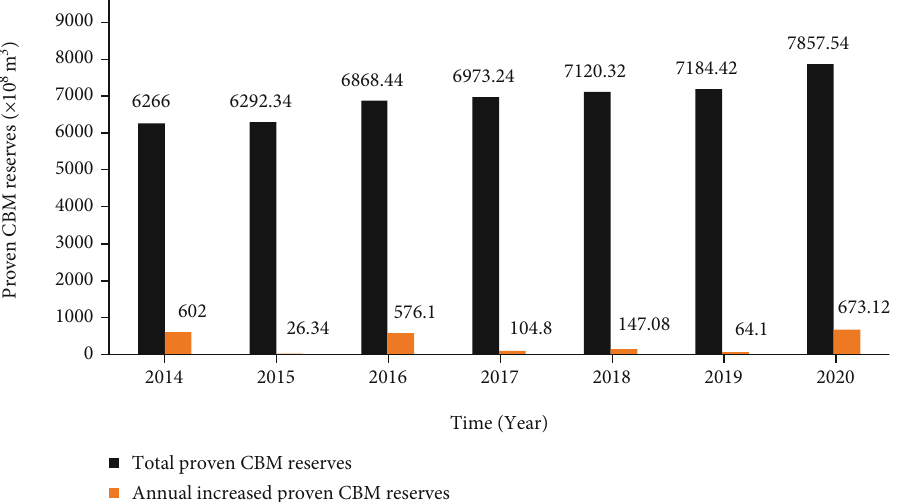
Figure 3: Annual proven CBM reserves in China